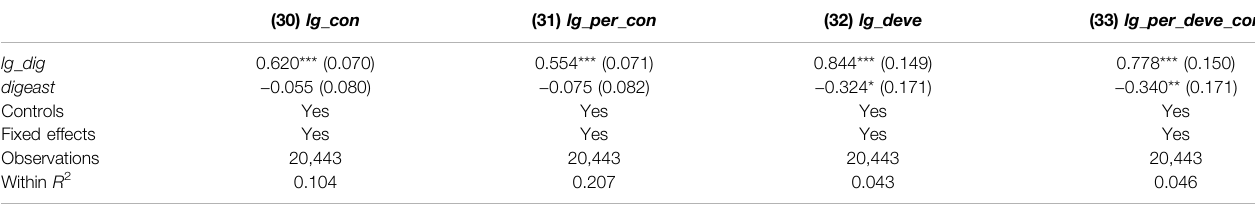
TABLE 7 | Heterogeneous analysis: rural households of different regions.